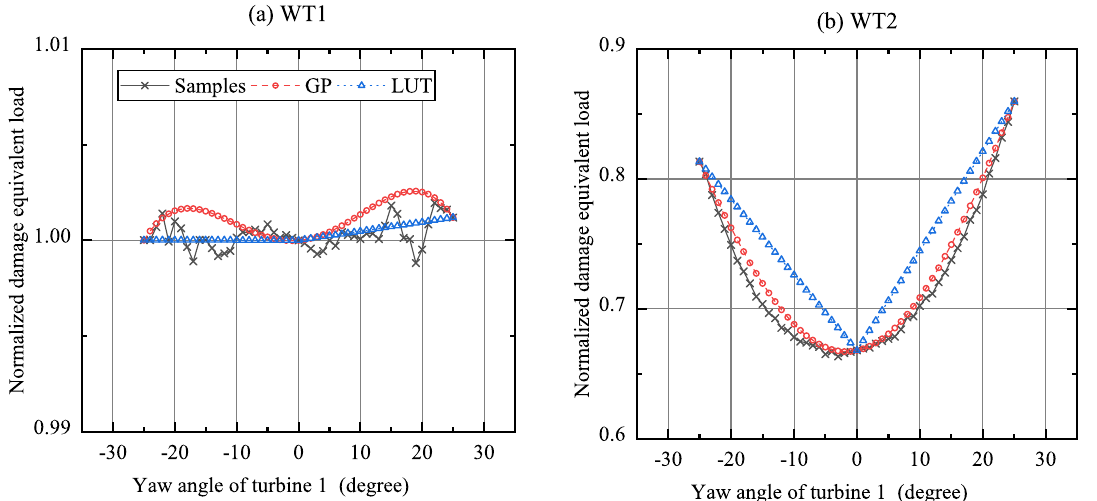
Figure 9. Prediction of normalized DEL-BREM by LUT and GP under yaw control mode Y1 and wind precursor P1.